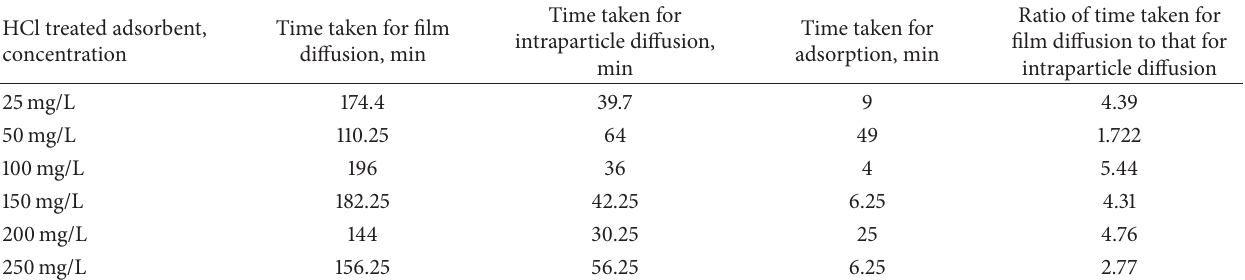
Table 6: The time taken by the adsorbent treated with KOH for the three different stages of adsorption. KOH treated